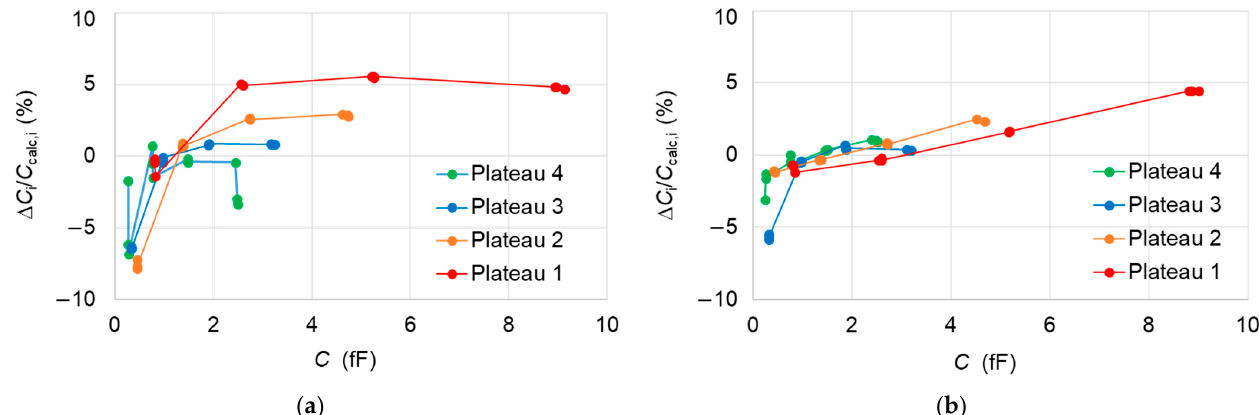
Figure 9. ( a ) Corrected differences Δ C i / C calc,i = ( C i,A45 − C i,A61 )/ C calc,i in percentage between the measured values C i,A45 on the 12 capacitors of a given plateau of A61F08 pattern when the SMM is calibrated using triplets from A45E08 pattern and the measured values C i,A61 when the SMM is calibrated with the equivalent triplets from A61F08. ( b ) Corrected differences Δ C i / C calc,i = ( C i,A64 − C i,A61 )/ C calc,i with the patterns A61E07 and A64F07 which replace A61F08 and A45E08, respectively. The error bars varying between 2% and 3% have been omitted for clarity.